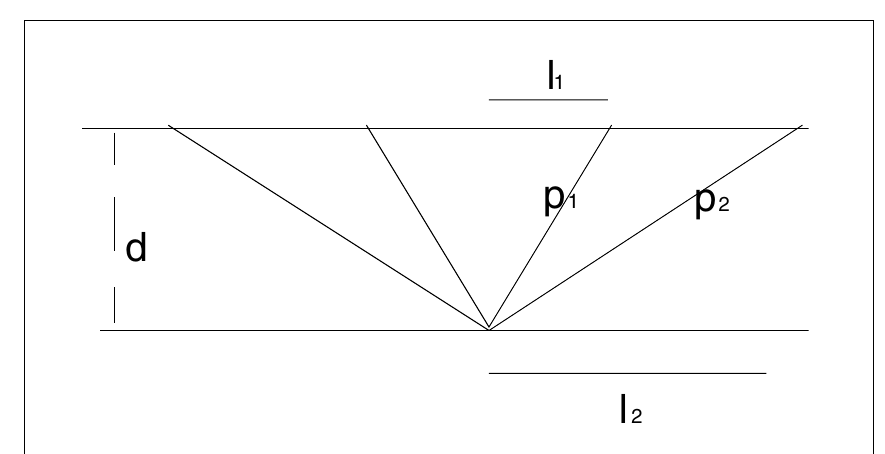
Fig. 1A. Geometrical scheme to retrieve the depth of a reflection from several measurements in common depth